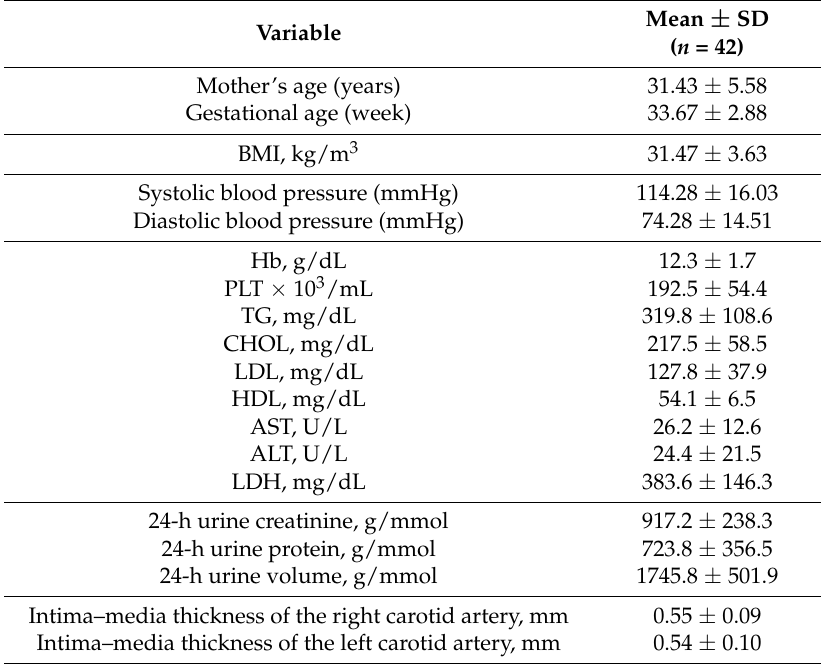
Table 1. Basic characteristics of the studied population in terms of mean and standard